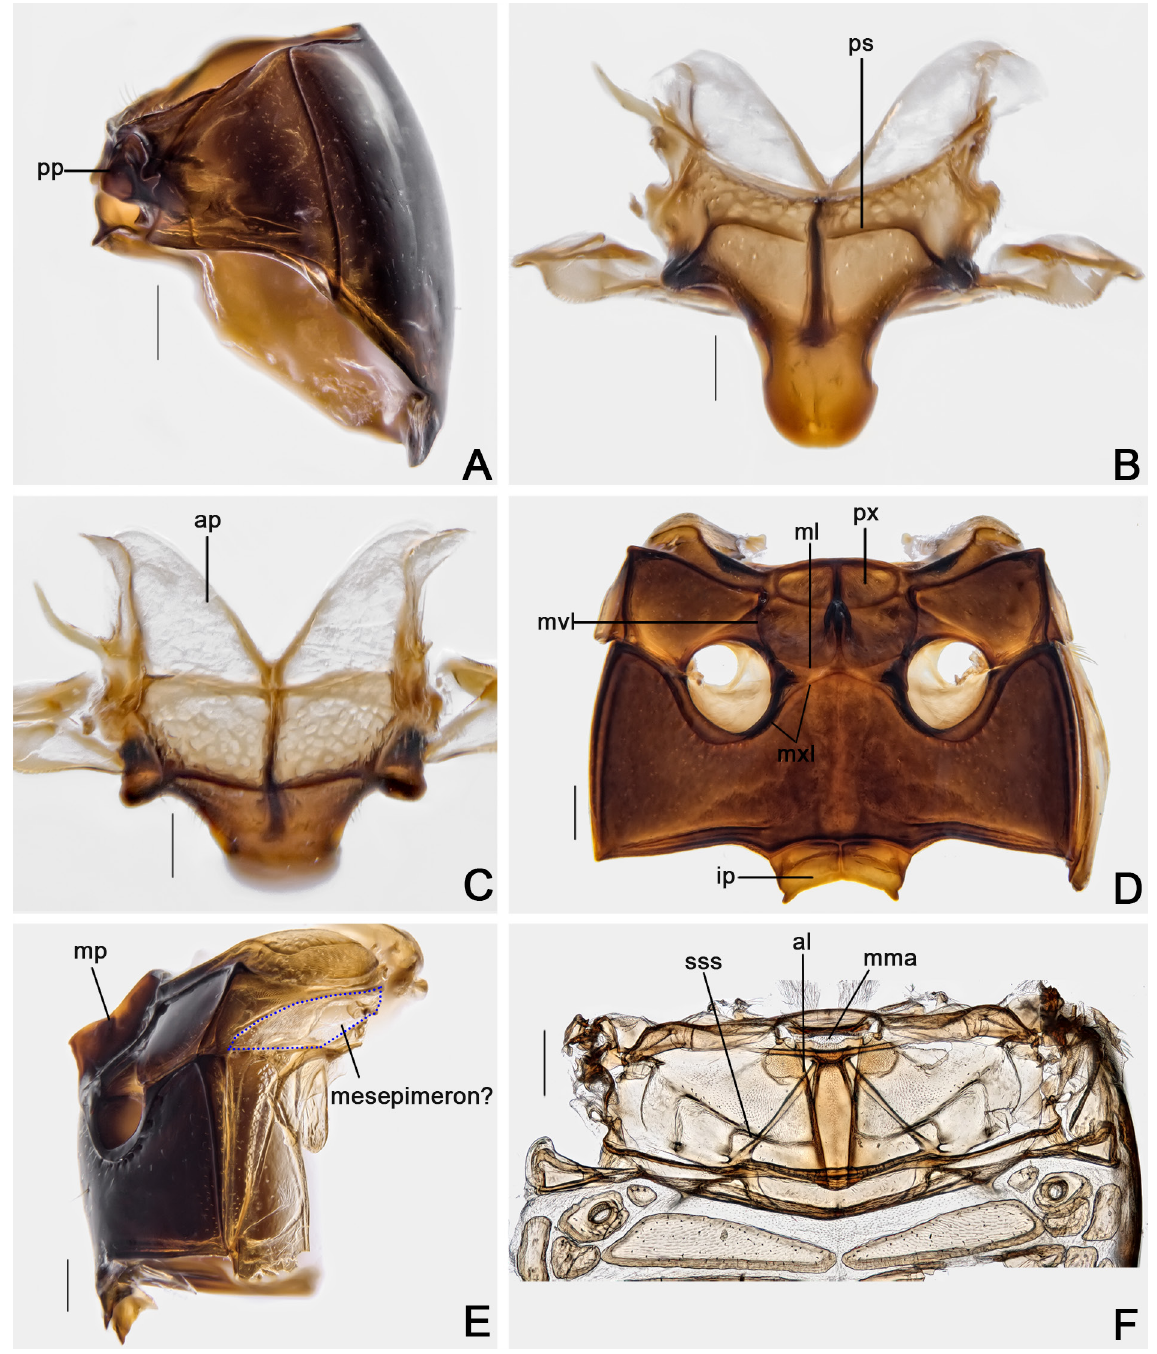
Fig. 9. Cyparium achardi sp. nov., paratype, ♂ (CELC). A . Prothorax, lateral view. B–C . Scutellar plate. B . Dorsal view. C . Apically slanted view. D–E . Meso- and metathorax. D . Ventral view. E . Lateral view. F . Metanotum. Specimen collected at Mata do Paraíso, Viçosa (MG, Brazil). Abbreviations: al = alacrista; ap = anterior phragma; ip = intercoxal plate; ml = median line; mma = median membranous area; mp = mesoventral process; mvl = mesoventral line; mxl = mesocoxal line; pp = prosternal process; ps = prescutellar line; px = procoxal rest; sss = scutoscutellar suture. Scale bars: A, D–F = 0.2 mm; B–C = 0.1